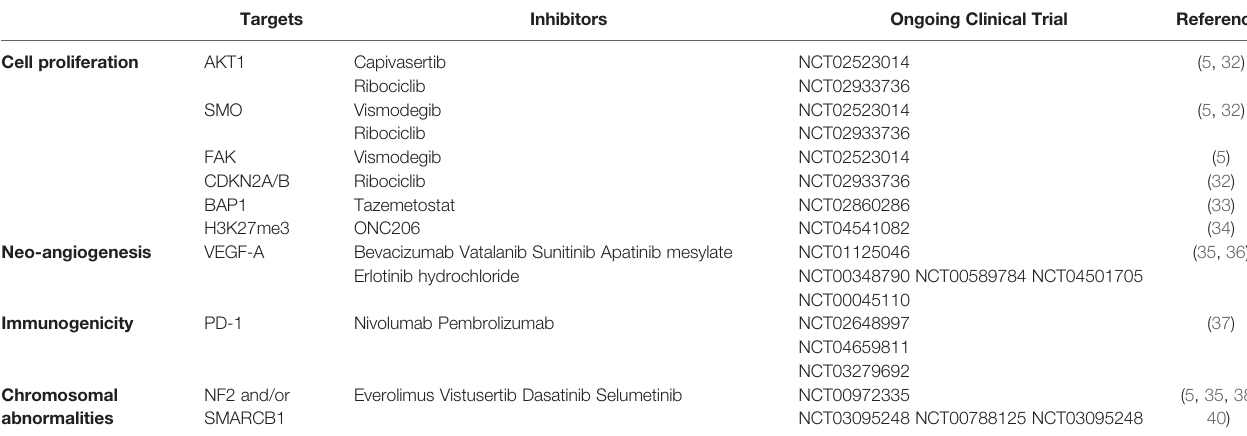
TABLE 1 | Summarization of key molecules and potential targeted therapy in recurrent and progressive meningiomas. Targets